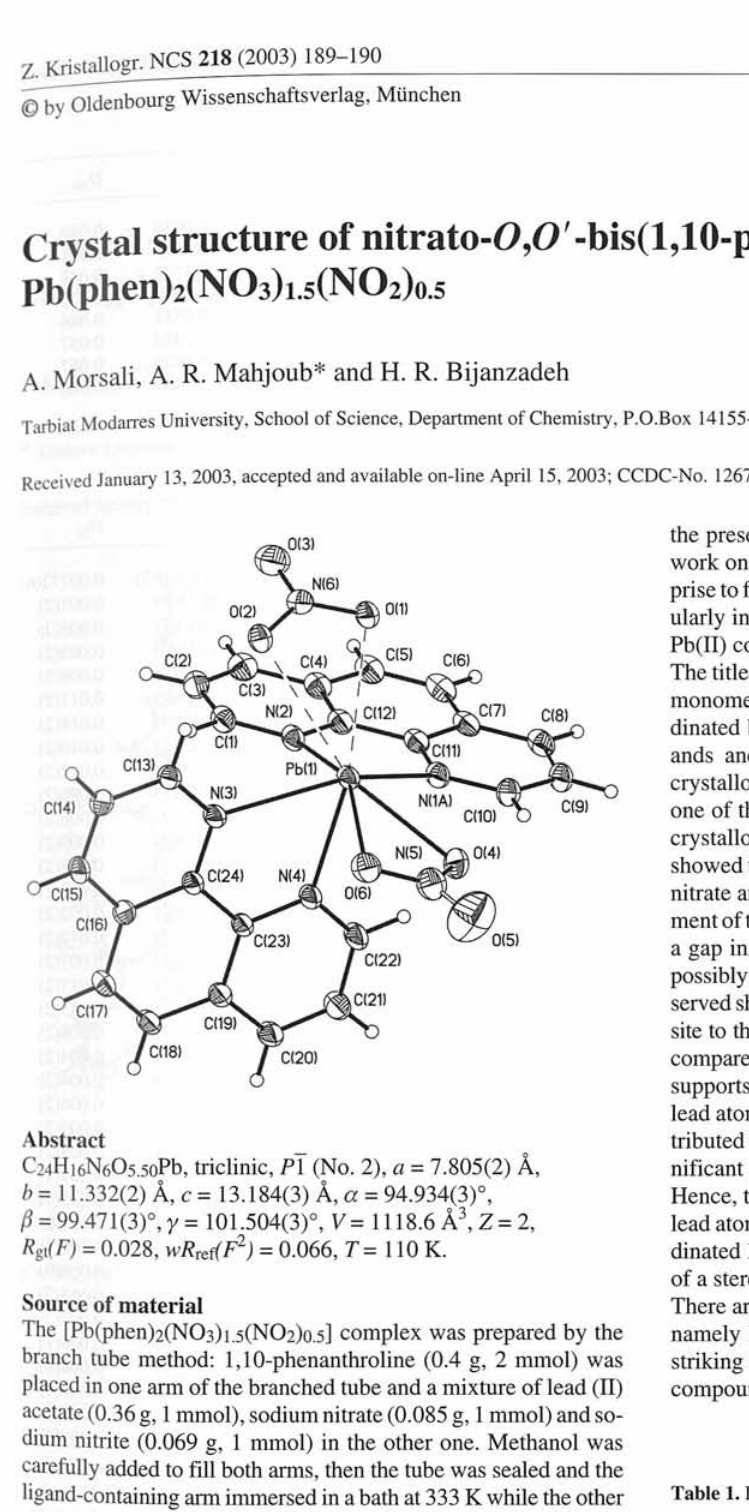
Table 1. Data collection and